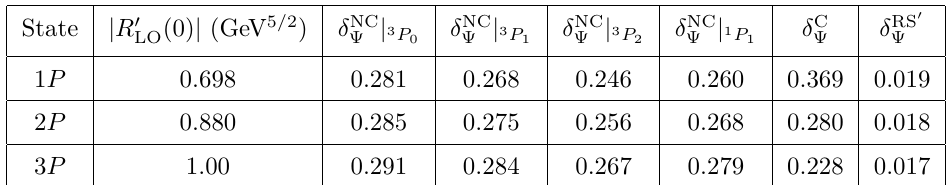
Table 2 . LO wavefunctions at the origin | R 0 (0) | and relative corrections to the wavefunctions at the origin in the MS scheme at scale Λ = m for 1 P , 2 P , and 3 P bottomonium states. δ NC the correction from the 1 /m and 1 /m 2 potentials, δ C correction from the RS 0 subtraction term. The δ NC